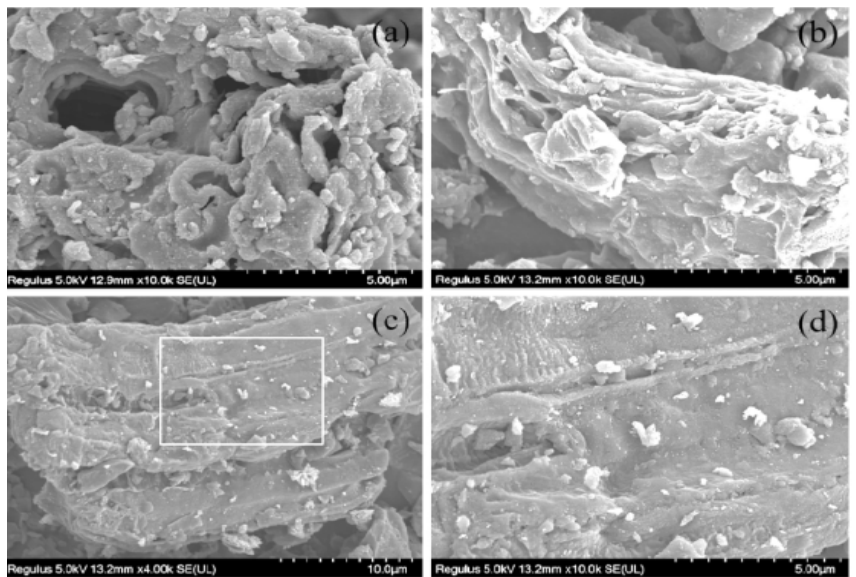
Figure 5. SEM analysis images of P-BC ( a , b ) before adsorption and ( c , d ) after adsorption adapted with permission from